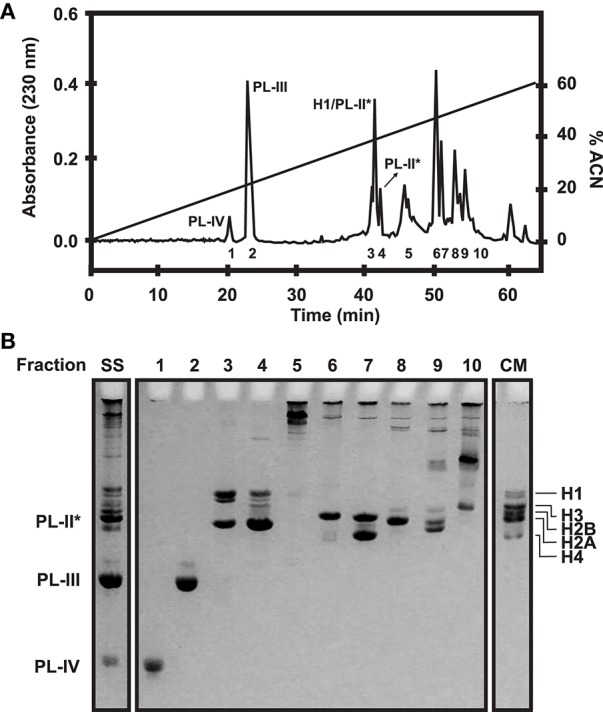
SNBP fractionation in bivalves. (A) RP-HPLC chromatogram of 1 mg of histones and SNBPs from Mytilus male gonad HCl extract using a Vydac C18 column (300 Å pore diameter). Peaks corresponding to the different SNBP components are indicated in the figure. The acetonitrile gradient employed in this experiment is indicated by a straight line (0–60%). (B) AU-PAGE separation of selected fractions corresponding to each peak. SS, starting sample; CM, chicken erythrocyte histones used as molecular marker.